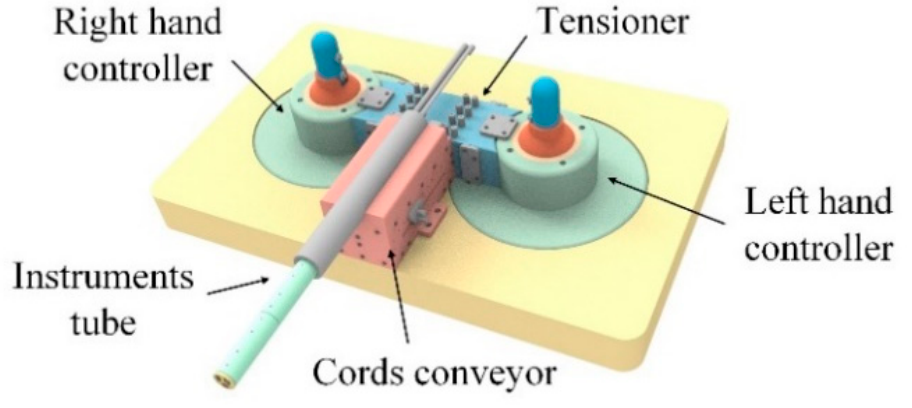
Figure 1. Overview of the designed single-port MIS training platform.